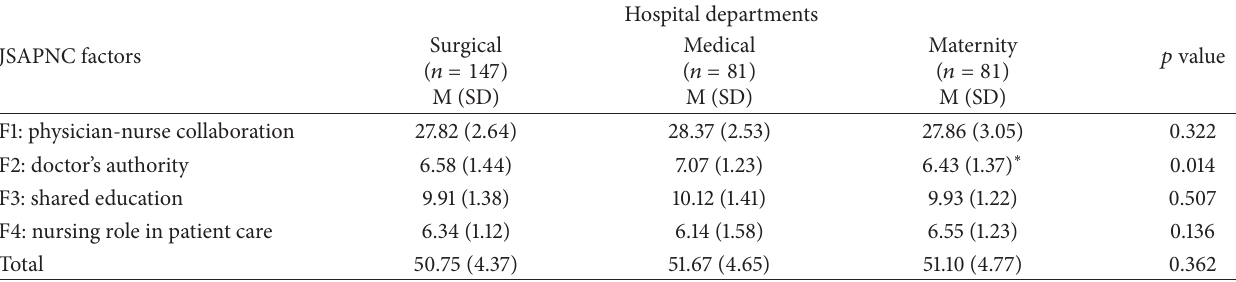
Table 4: Attitude of nurses toward nurse physician collaboration factors according to place of work.